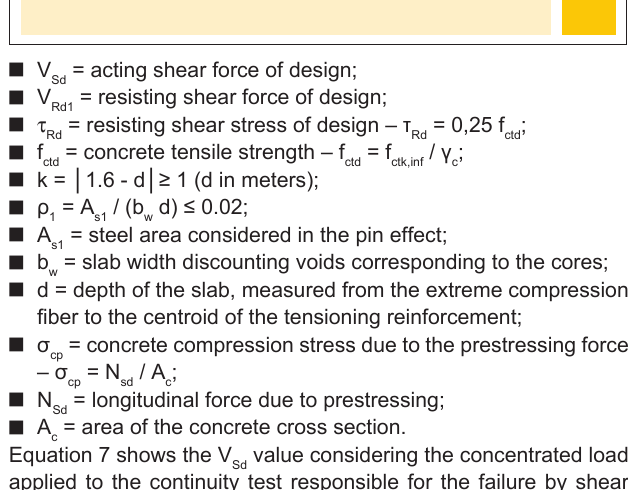
Figure 11 – Flow chart of the calculation of A by the criteria suggested for the maximum r esistance moment of the hollow core